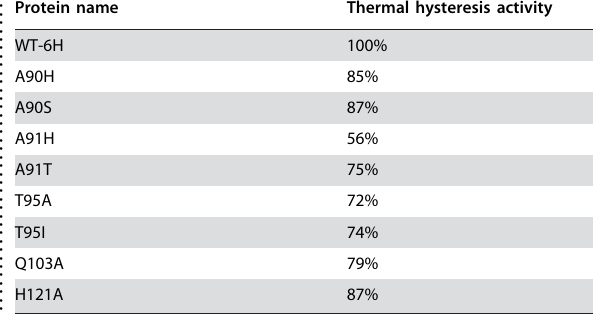
Table 2. Relative thermal hysteresis activities of hAFP